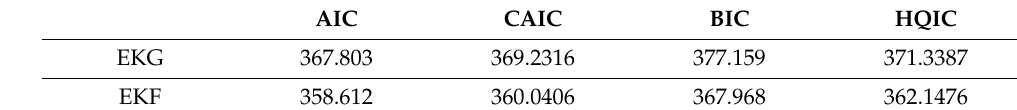
Table 9. AIC, BIC, CAIC, and HQIC for different sets and different model for Wire data.